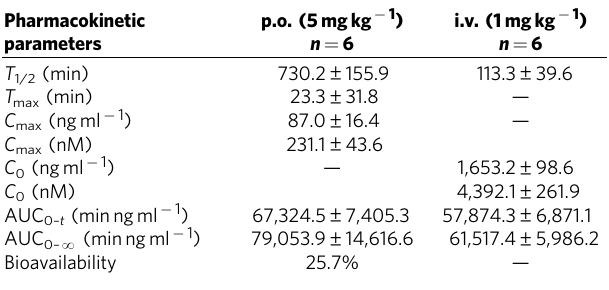
Table 1 | The pharmacokinetic parameters of AIL after oral administration or intravenous injection in rats (mean ±